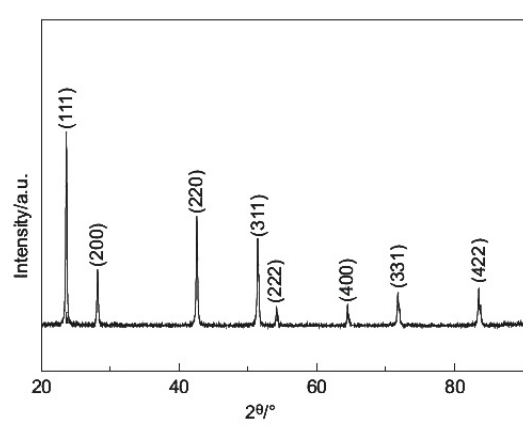
Fig.1. XRD pattern of nanoparticles